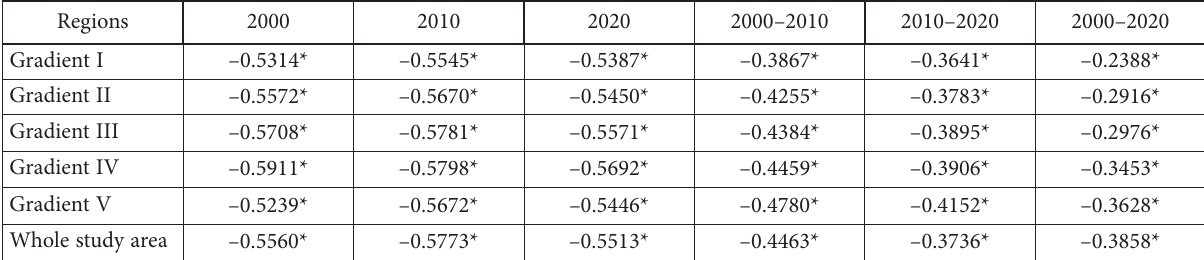
Table 6. Correlation coefficient between habitat quality and human activity intensity in Guiyang Regions